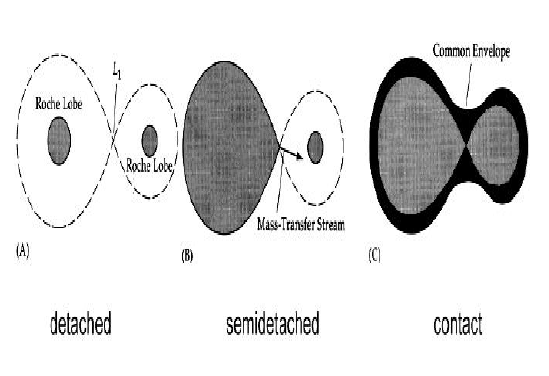
Fig.1: The three types of the binary star systems depending on their Roche lobe